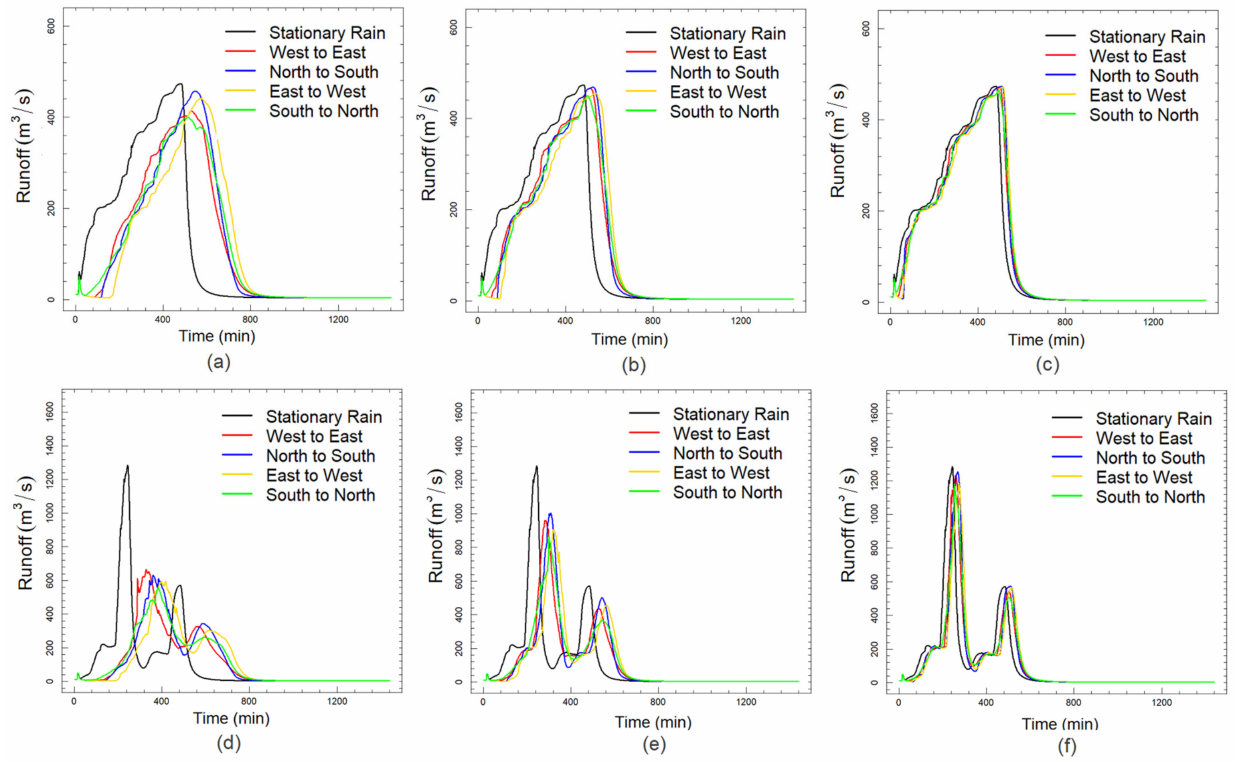
Figure 12. Hydrographs (at measuring point A) for rain variabilities σ 2 = 0 ( a – c ) & 99.2 ( d – f ) for stationary and non-stationary rain setups with velocities v = 5, 10, and 25 km/h (from left to right respectively) for storms moving in four